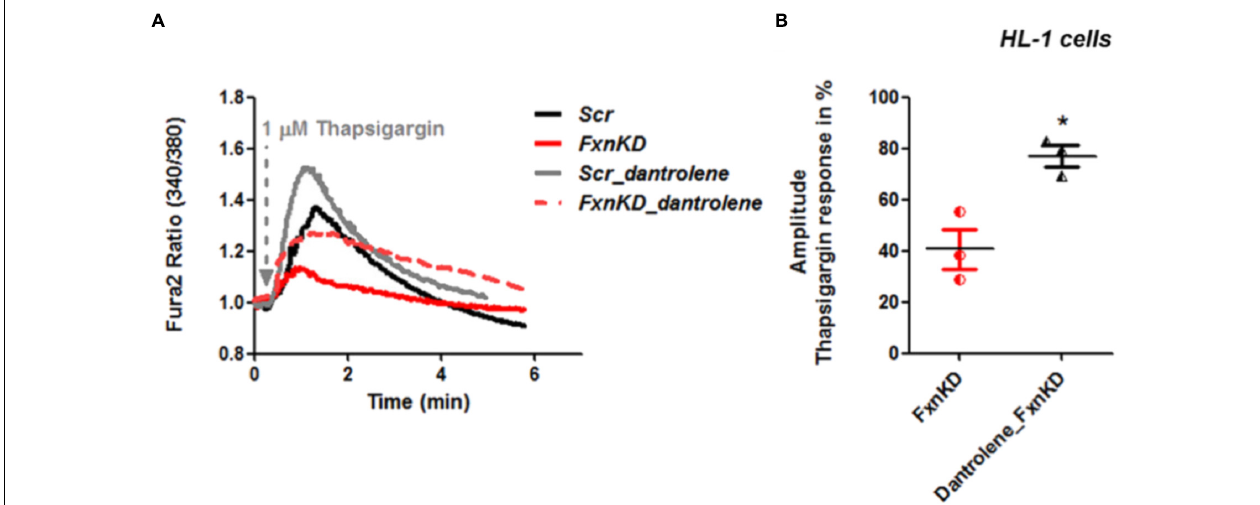
FIGURE 6 | Dantrolene prevents SR Ca 2 + store depletion in FxnKD cardiomyocytes. (A) HL-1 cells show an increased calcium response after pre-incubation with dantrolene, an inhibitor of RyRs. (B) Comparing the response between FxnKD and Dantrolene_FxnKD we found a significant increase of the thapsigargin–induced calcium response in dantrolene pre-treated FxnKD, demonstrating that the RyRs were not inhibited ( ∗ p < 0.05).